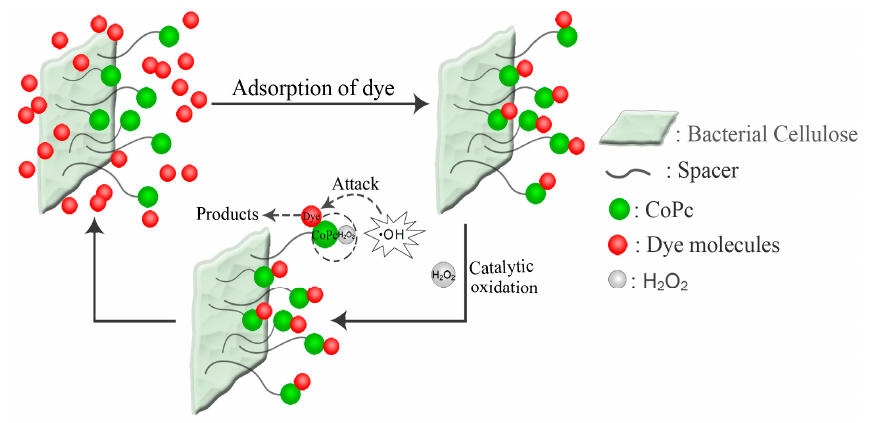
Figure 10. Possible pathway for the catalytic oxidation of reactive red X-3B by CoPc@s-BC/H 2 O 2 .